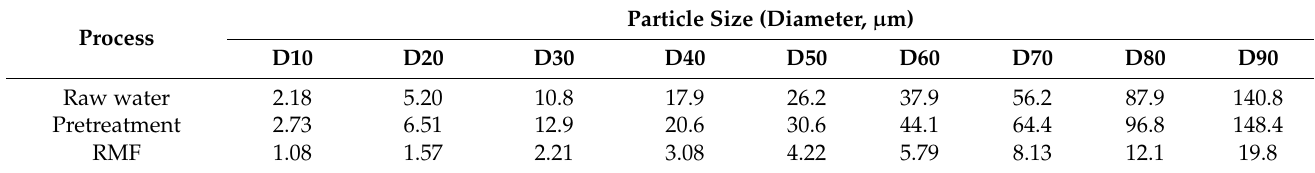
Table 4. Particle size distribution of each